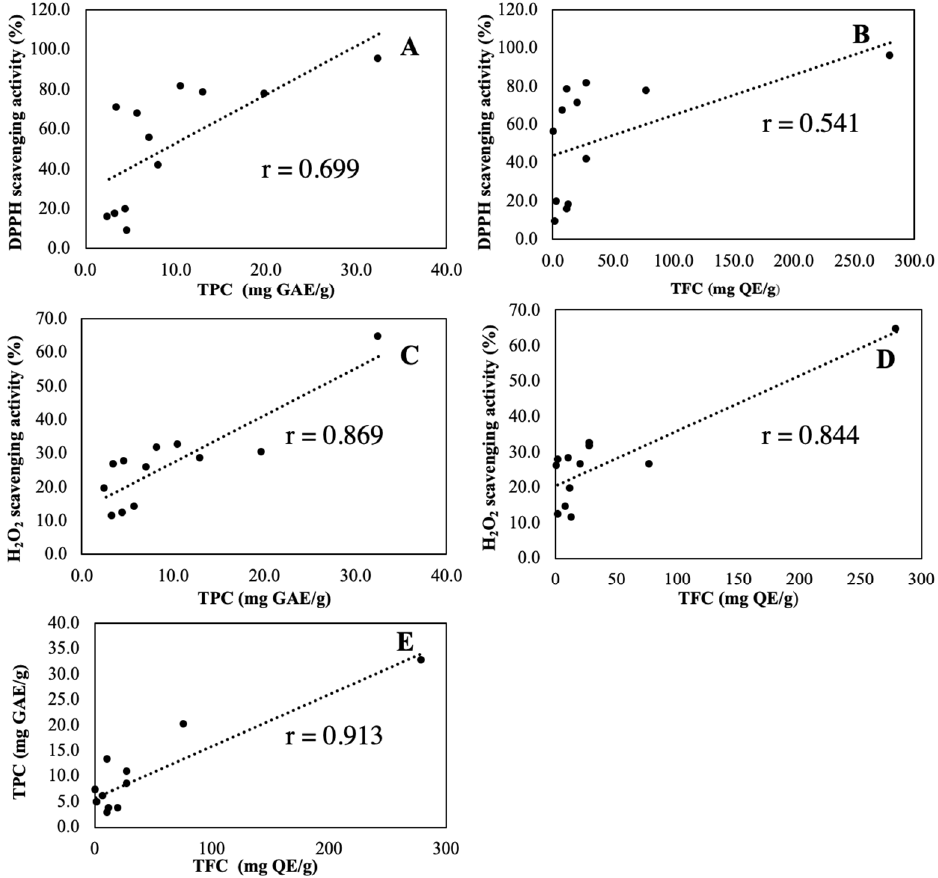
Figure 4. Pearson correlation scatter plot of relationship between ( A ) AA and TPC, ( B ) AA and TFC, ( C ) AA (H 2 O 2 ) and TPC ( D ) AA (H 2 O 2 ) and TFC, and ( E ) TPC and TFC.